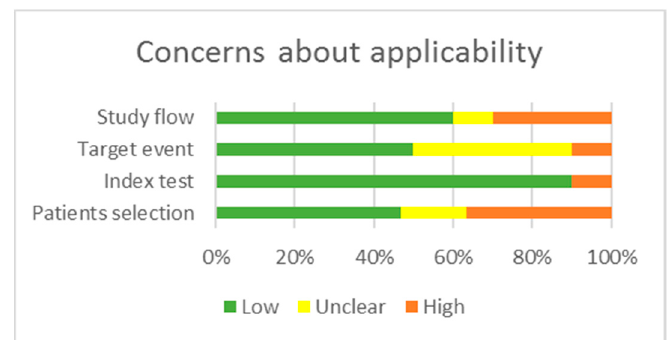
Figure 2. Risk of bias of the included studies.